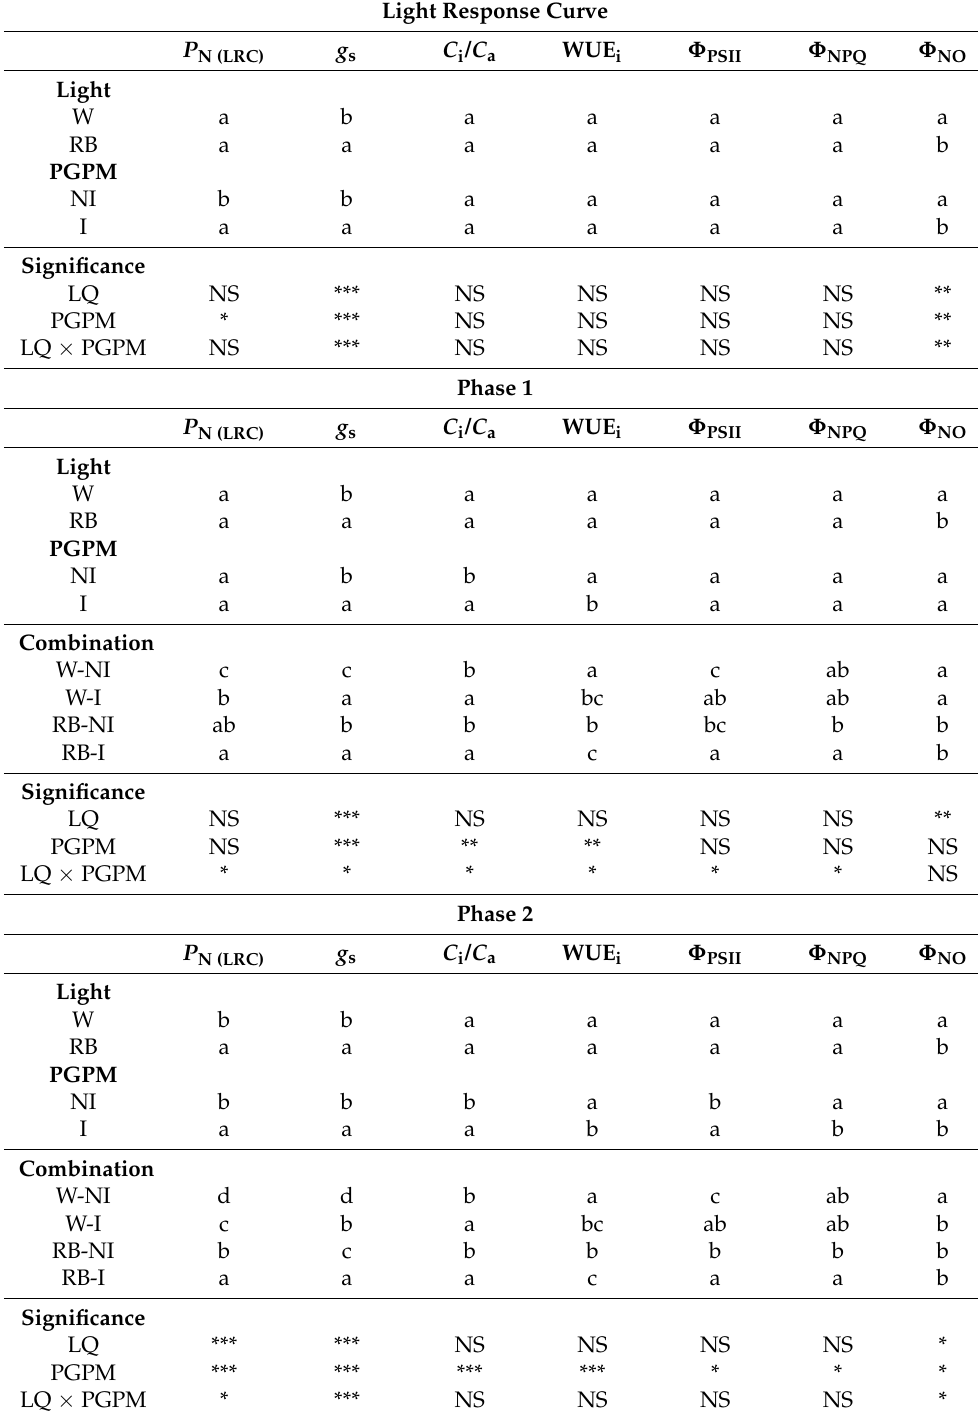
Table 2. Analysis of variance and comparison of means for the light response curve (LRCs)-derived photosynthetic functional traits P N(LRC) , g s , C i / C a , WUE i , Φ PSII , Φ NPQ , Φ NO in response to light quality (LQ), plant-growth promoting microbes (PGPM), and their interaction (LQ × PGPM). Different letters in each column indicate significant differences according to Student–Newman–Keuls (SNK) test ( p ≤ 0.05). NS—not significant; * p ≤ 0.05; ** p ≤ 0.01; *** p ≤